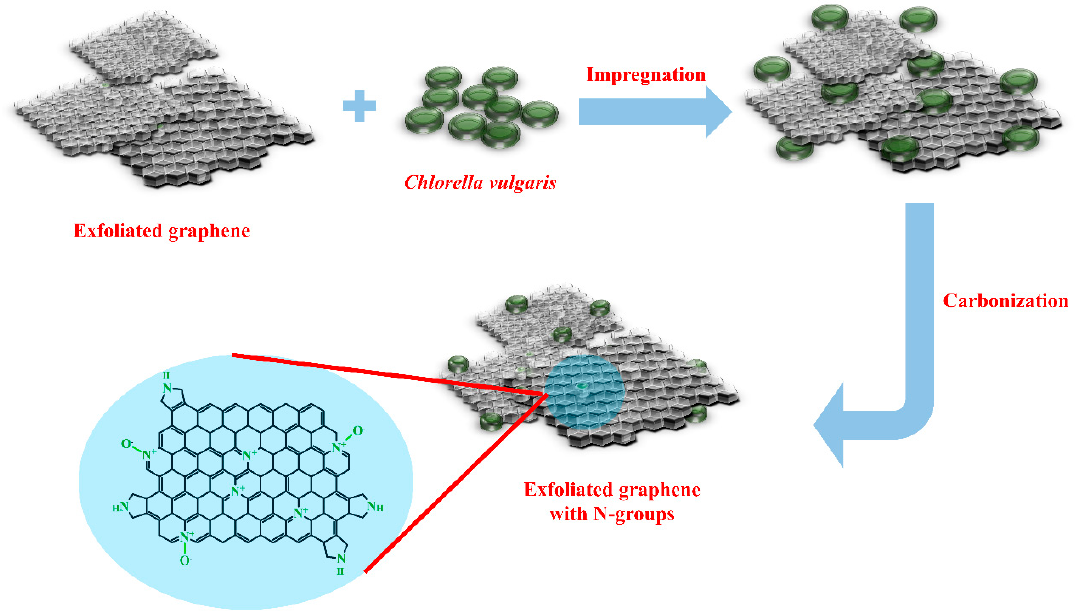
Figure 1. Preparation procedure of N-doped exfoliated graphene synthesis involving electroexfoliation of graphite and Chlorella vulgaris as the nitrogen source.